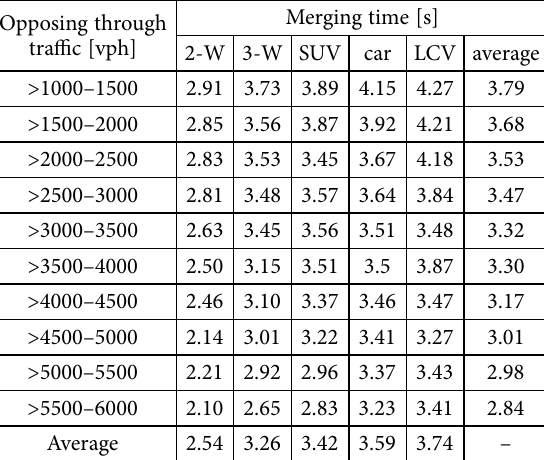
Table 4. MT statistics for different categories of vehicles